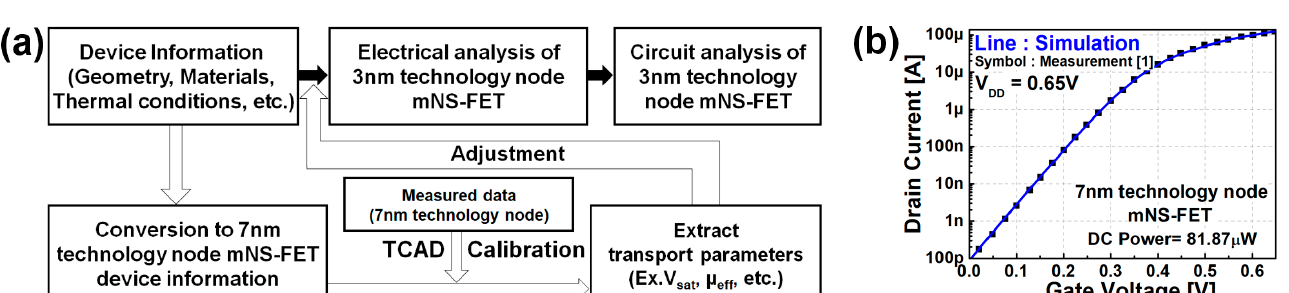
Figure 2. ( a ) Overall workflow for the analysis of mNS-FET, ( b ) I DS versus V GS calibration result based on the measurement of a fabricated mNS-FET. based on the measurement of a fabricated